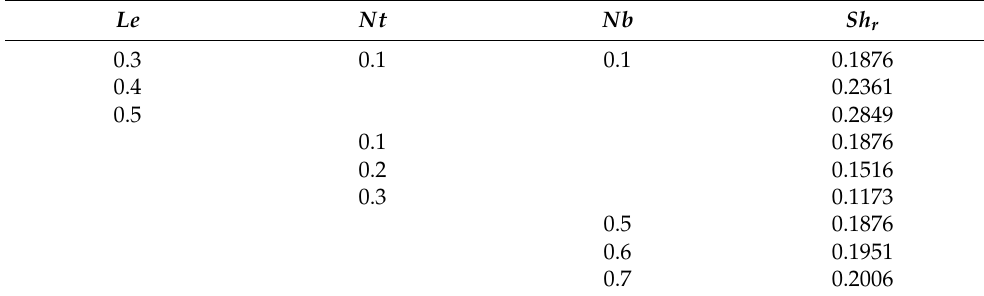
(cid:113) − 1 n + 1 2 x Sh x = − φ (cid:48) ( 0 ) . 2